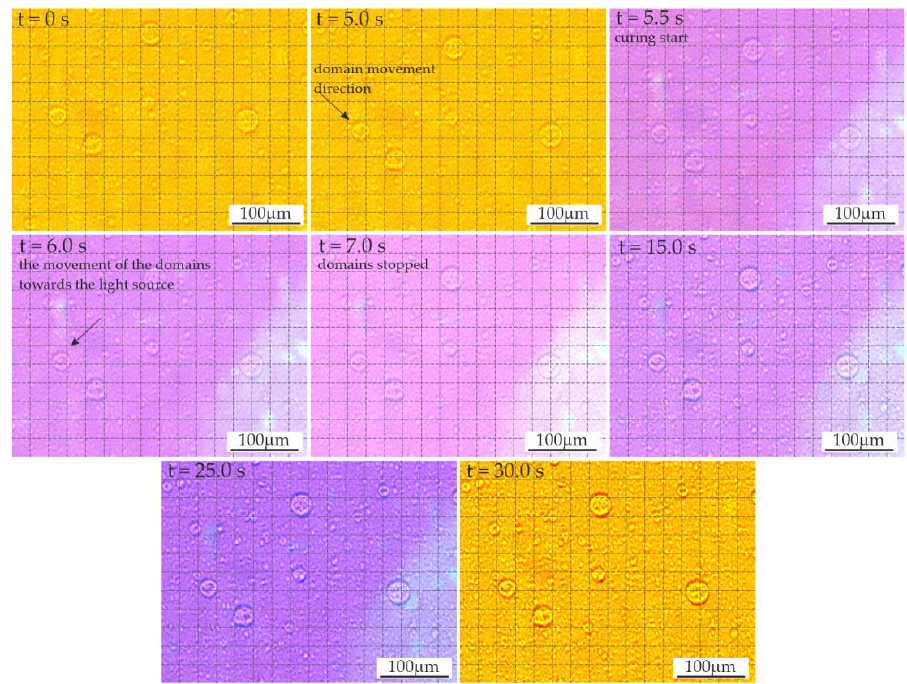
Figure 5. The dynamics of polymerization in the video sequence recorded for resin F containing 3 wt.% liquid rubber. 3 wt.% liquid rubber.